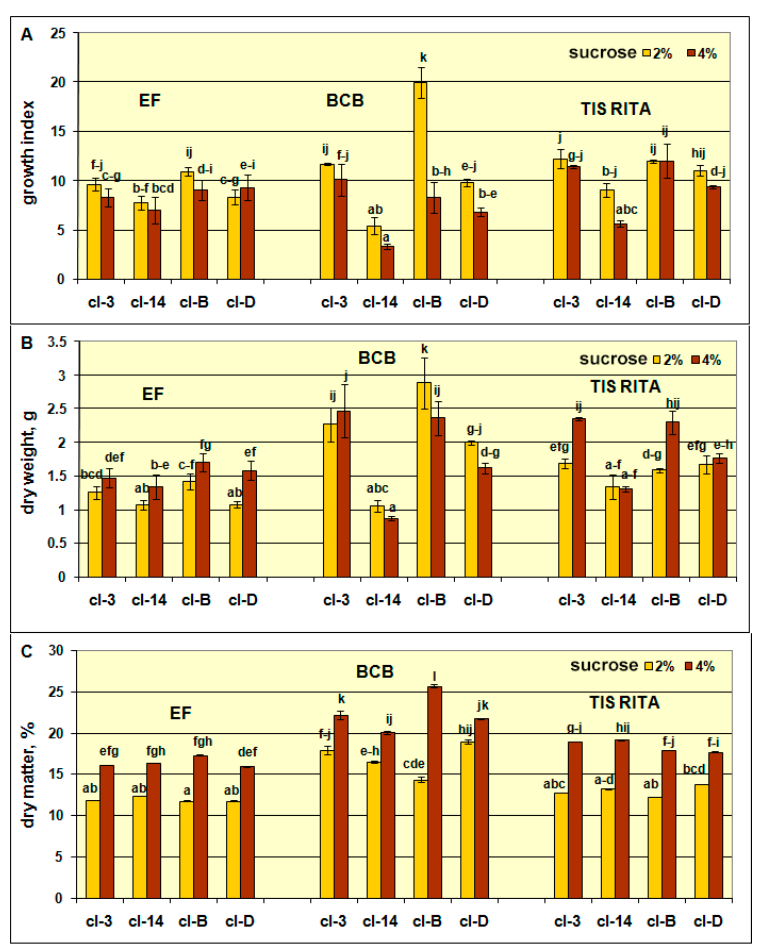
Figure 2. Growth index ( A ), dry weight ( B ), and percentage of dry matter ( C ) of Gentiana dinarica hairy root clones cl-3, cl-14, cl-B, and cl-D, after 7 weeks of cultivation in Erlenmeyer flasks (EF), bubble column bioreactor (BCB), and temporary immersion systems (TIS) RITA ® . Presented values are mean ± SE of 3–6 replicates. Within each parameter, values with the same letter are not significantly different at the p ≤ 0.05 level according to Fisher’s least significant difference (LSD) test.